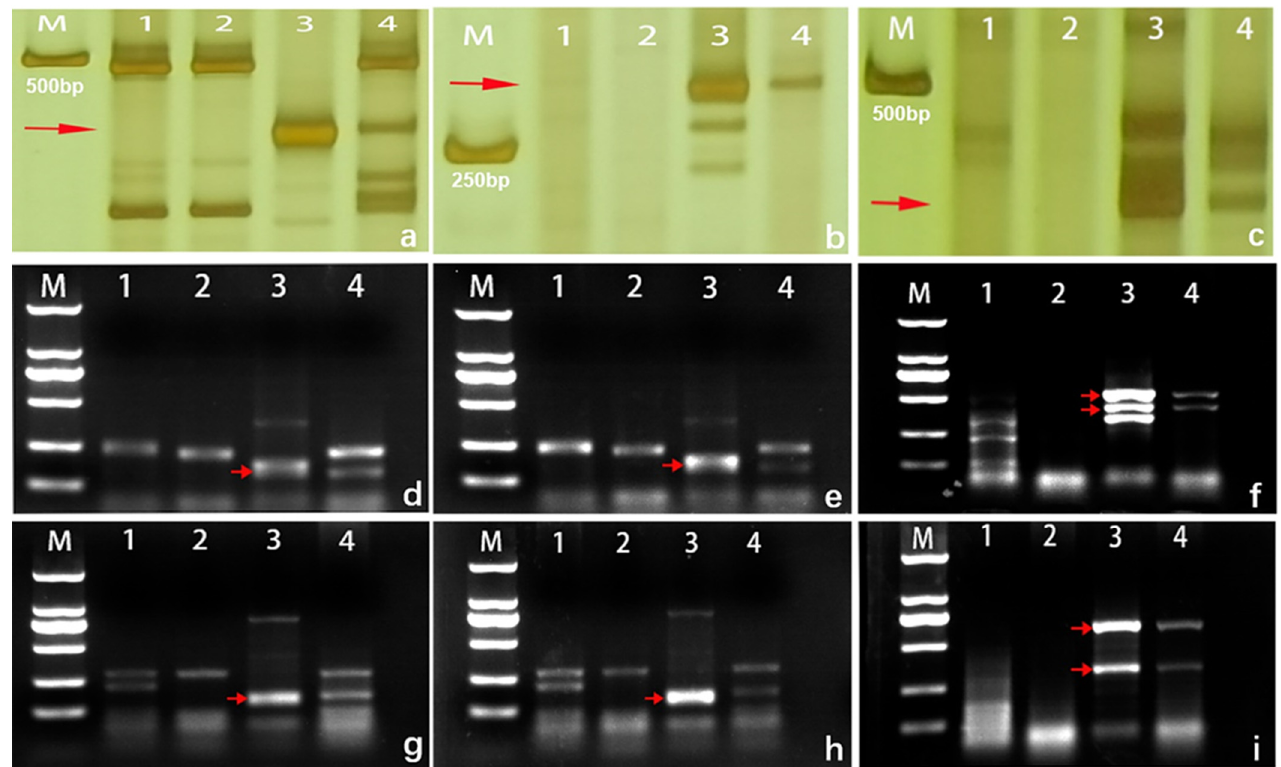
Figure 4. EST–STS and PLUG markers analysis of wheat- Leymus mollis disomic substitution line 17DM48. The red arrows indicate the L. mollis specific band. (M). DNA marker DL2000. ( 1 ) 7182. ( 2 ) D4286. ( 3 ) L. mollis . ( 4 ) 17DM48. ( a ) BG607805. ( b ) CD453246. ( c ) BQ169707. ( d ) TANC1204-TaqI. ( e ) TANC1210-TaqI. ( f ) TANC1139-TaqI. ( g ) TANC1210-HaeIII. ( h ) TANC1204-HaeIII. ( i ) TANC1139-HaeIII.